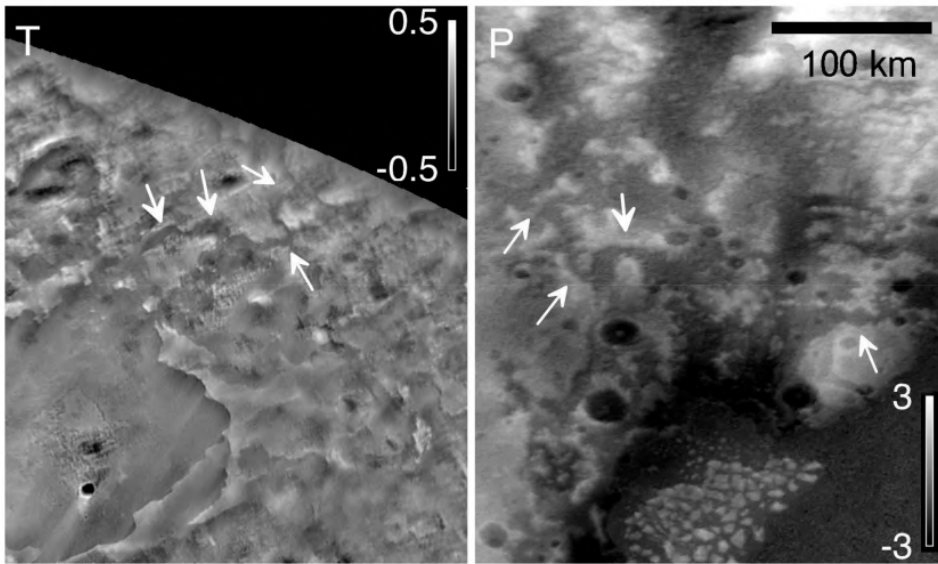
Figure 30. DEMs of (T) Triton and (P) Pluto showing sinuous channel-like features (arrows). Images shown to same scale (0.350 km/pixel) and scenes are ~300 km wide. Topography used in these views to highlight channel-like morphologies.